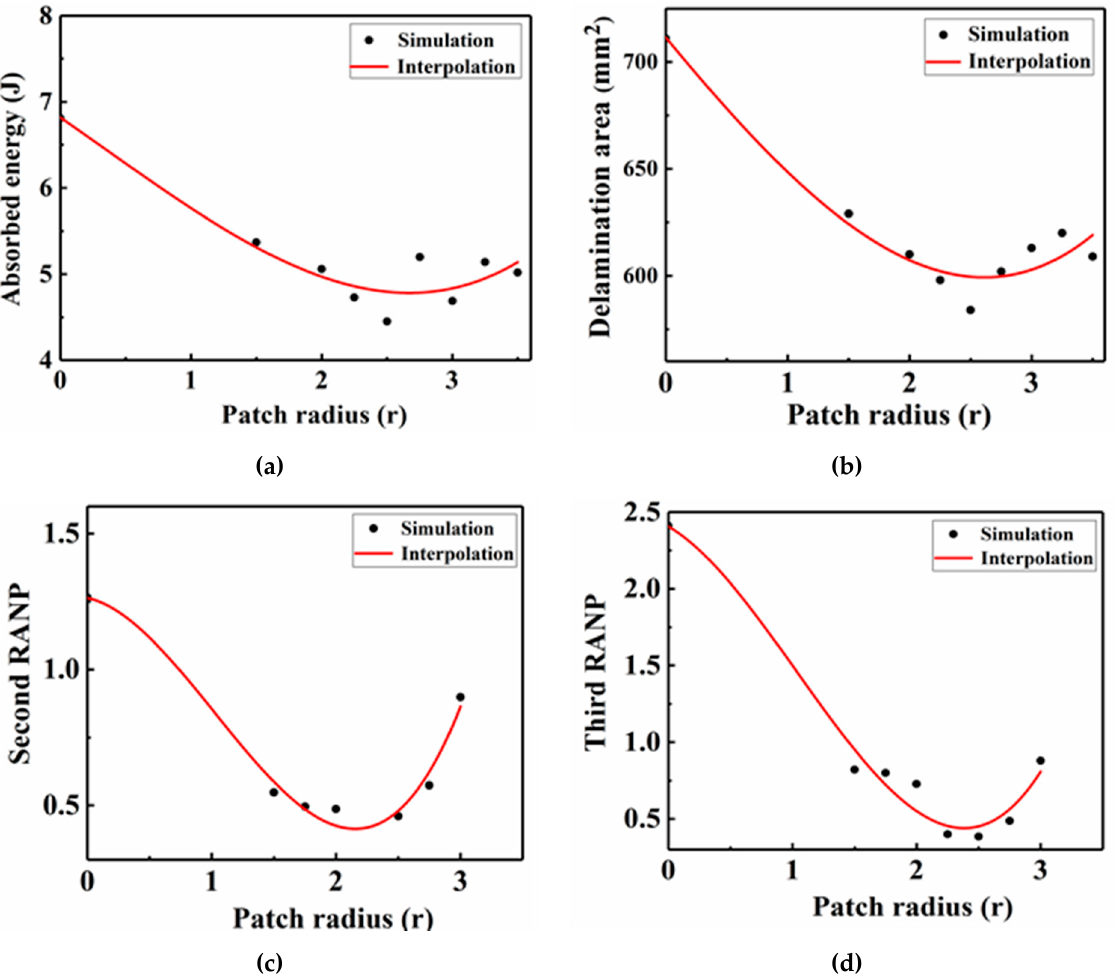
Figure 22. Interpolation relationships of the patch radius with the ( a ) absorbed energy, ( b ) delamination area, ( c ) second RANP and ( d ) third RANP.